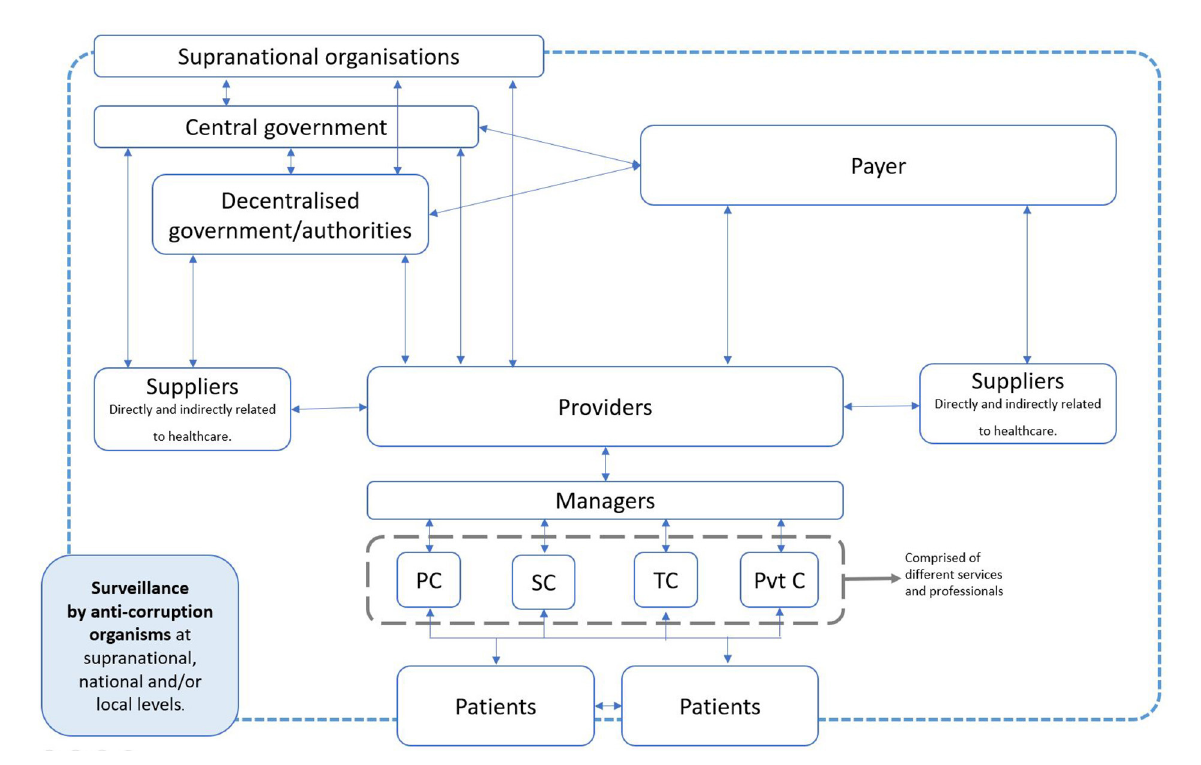
FIGURE1 Interactions of actors of a health system. PC, primary care; SC, secondary care; TC, tertiary care; Pvt C, private care. Source: Gonzalez-Aquines et al. (10).